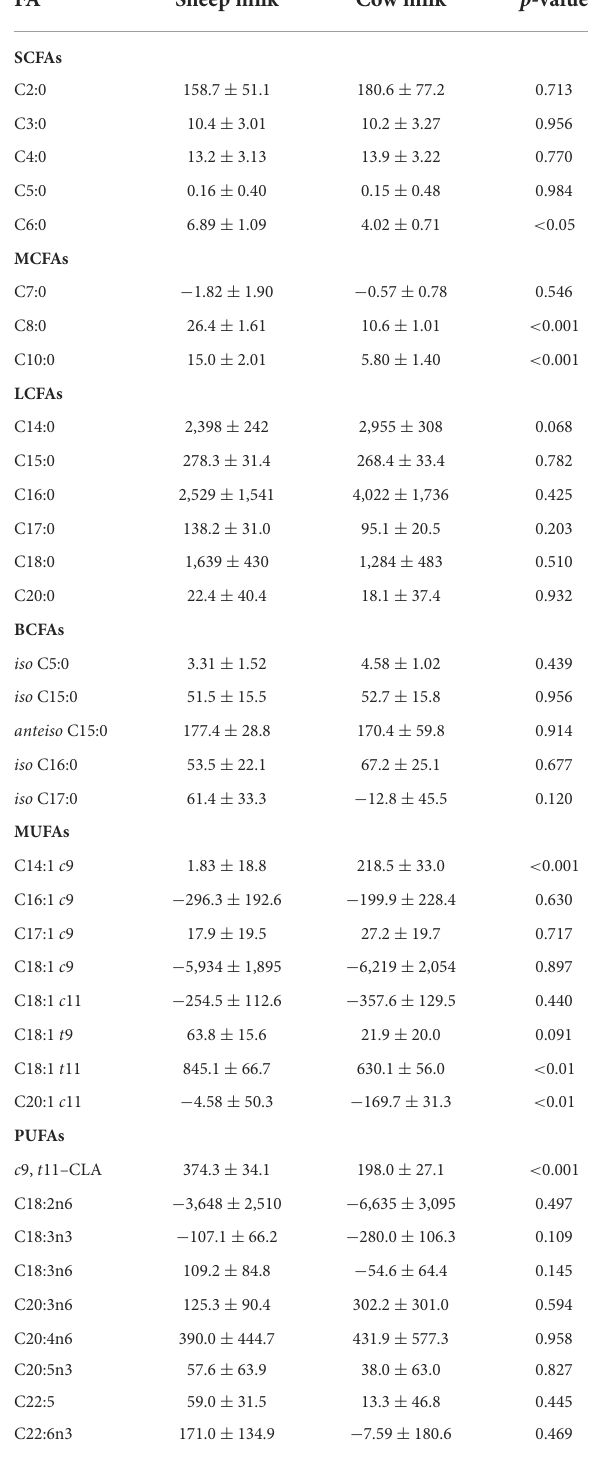
TABLE 4 Fatty acid iAUC ( µ g · min/mL) in blood plasma following sheep and cow milk ingestion. FA Sheep milk Cow milk p-